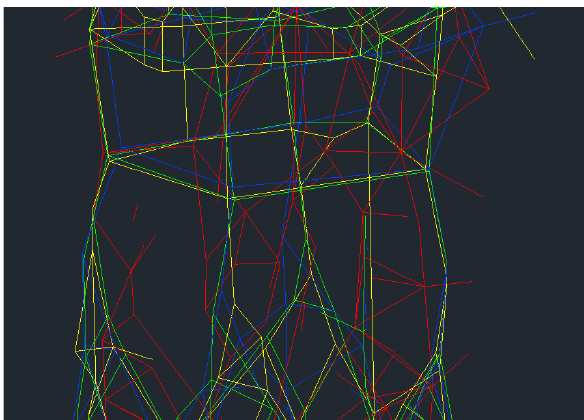
Figure 10. Comparison between the structure extracted from the matrices filtered at 0 (red), 20 (yellow), 50 (green) and 100 (blue) points per